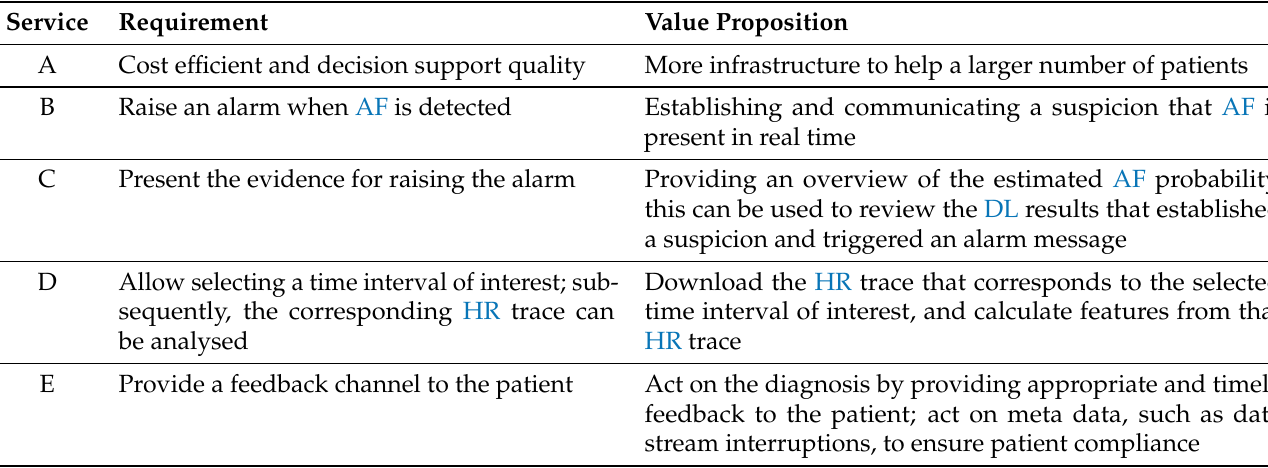
Table 2. Service requirements and their associated value